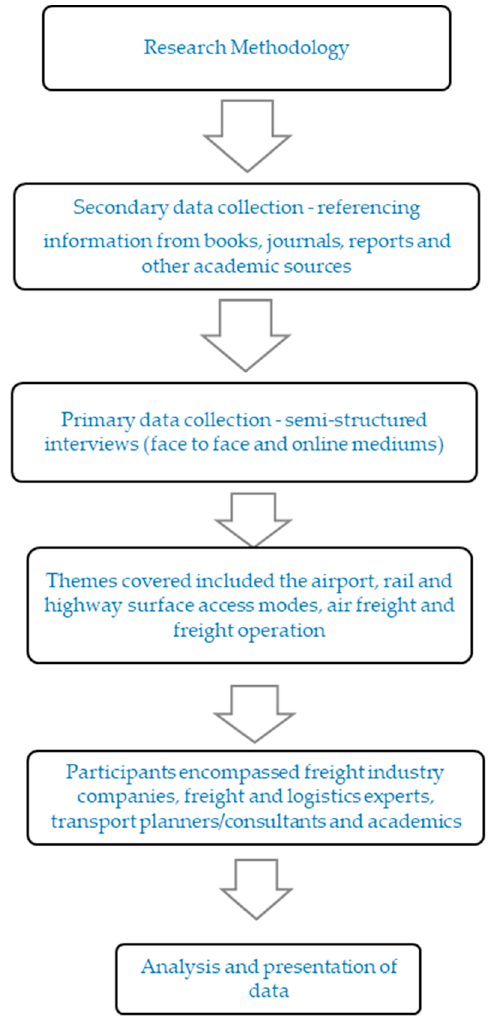
Figure 2. Data flow chart of methodology. Table 2. Coding used for interview